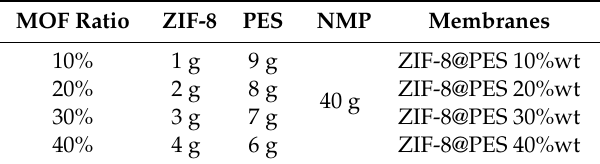
Table 1. Metal organic framework (MOF) ratios for preparation of casting